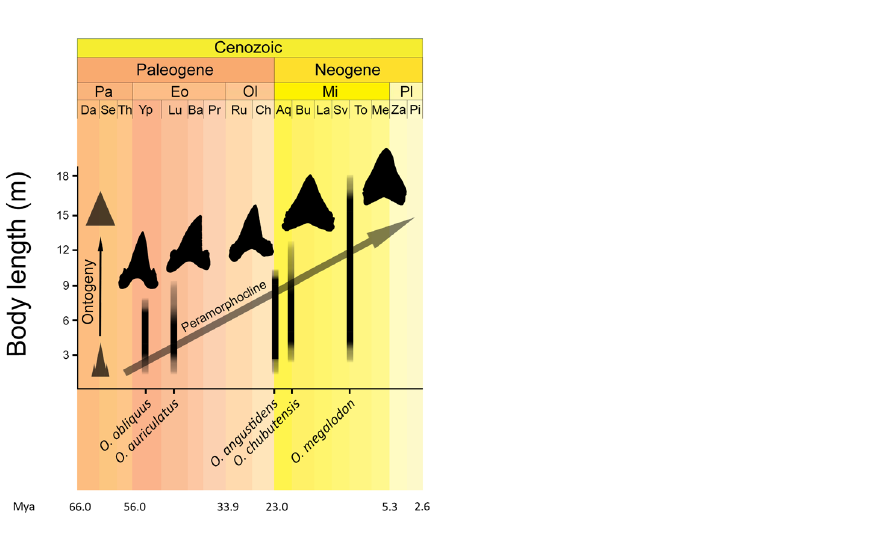
Figure 3. Schematic representation of the trends in tooth morphology, body size and presumed heterochronic phenomena through the evolution of otodontid